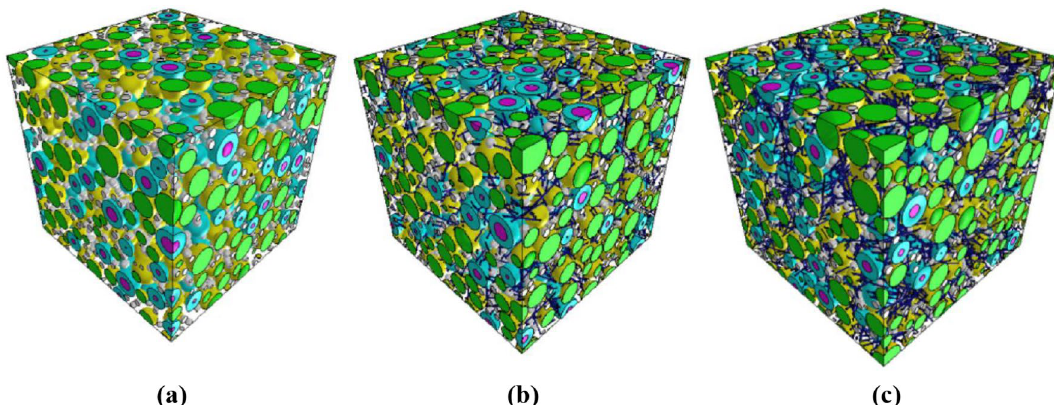
Figure 7. FRRAC at fiber contents of: ( a ) 0, ( b ) 1, and ( c ) 2%.